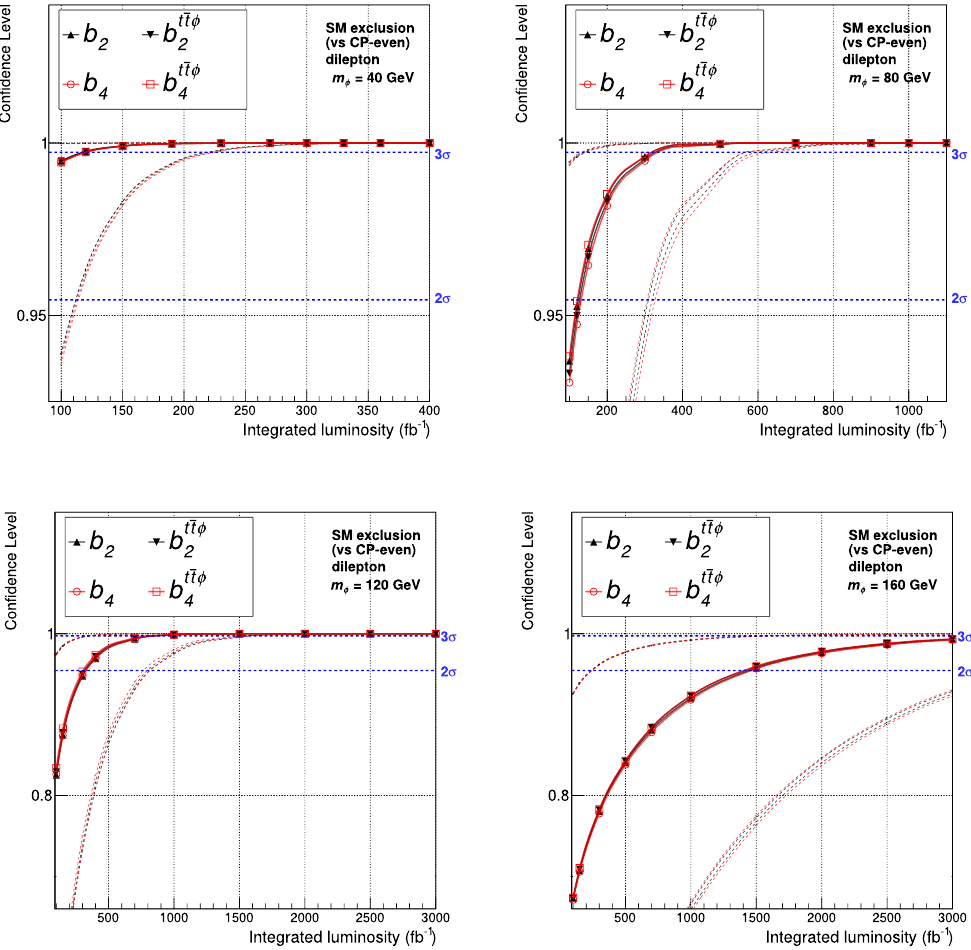
Figure 20. Expected CLs for SM exclusion assuming the SM plus a new CP-even scalar particle (scenario 4), as a function of the integrated luminosity.